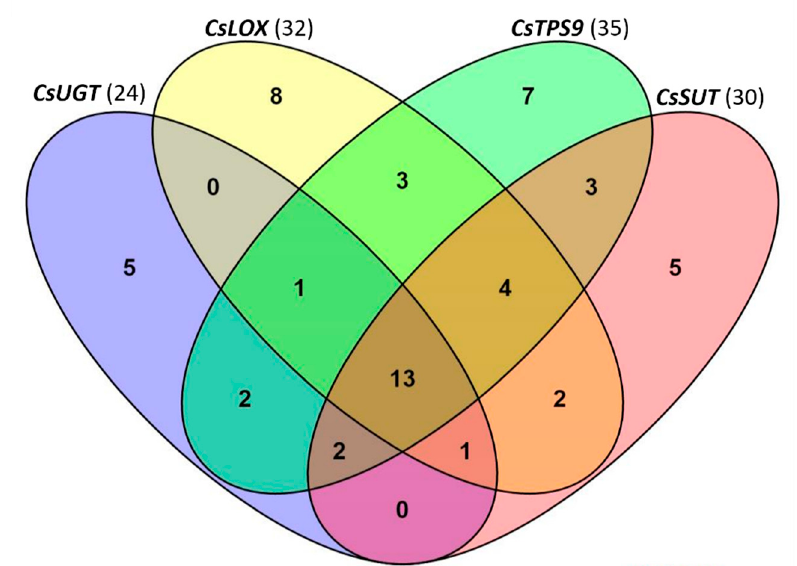
Figure 6. Specific and shared binding motifs found in promoter sequences of CsLOX (upregulated), CsTPS9 (upregulated), CsUGT (downregulated) and CsSUT (downregulated). Total number of motifs for each gene is indicated in brackets following the gene name.